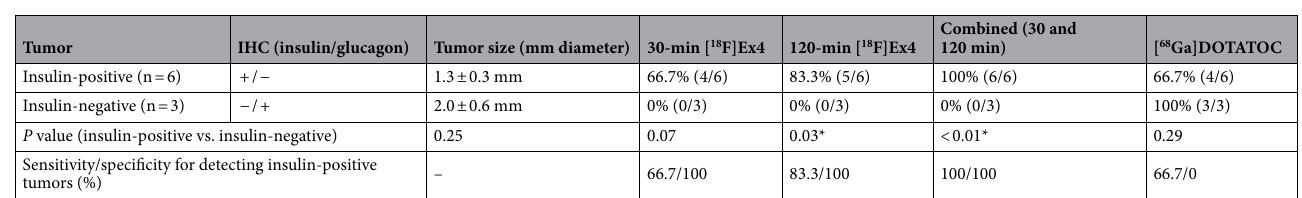
Table 2. The comparative results of [ 18 F]FB(ePEG12)12-exendin-4 and [ 68 Ga]DOTATOC PET/CT. The data are expressed as the mean ± SEM. IHC immunohistochemistry, [ 18 F]Ex4 [ 18 F]FB(ePEG12)12-exendin-4, PET/ CT Positron emission tomography/Computed tomography, 30-min PET scans started 30 min after the probe injection, 120-min PET scans started 120 min after the probe injection; *P <